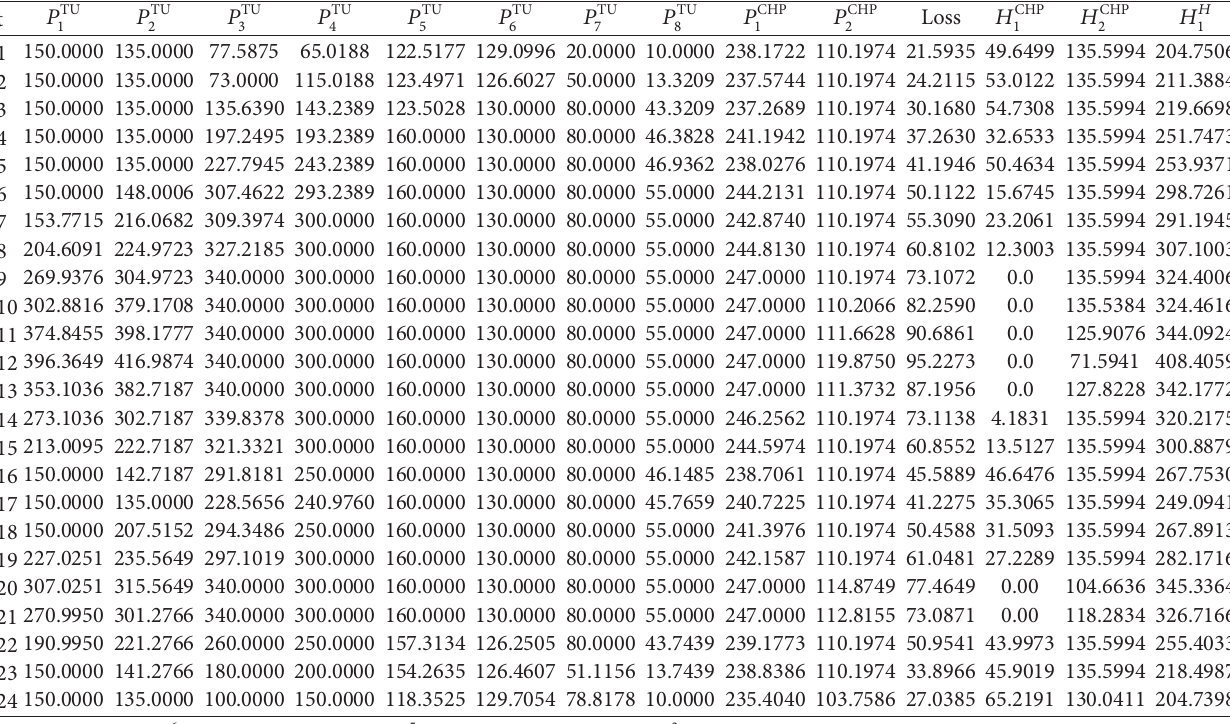
Table 6: Hourly heat and power schedule obtained from CHPDEED ( 𝑤 = 0.5